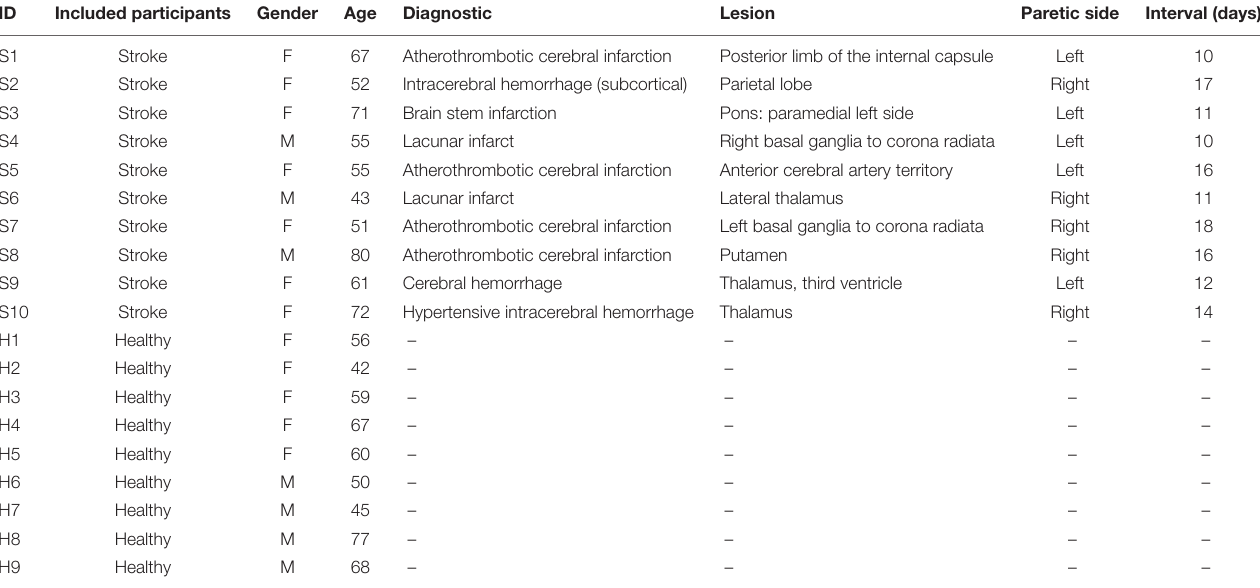
TABLE 1 | Characteristics of the